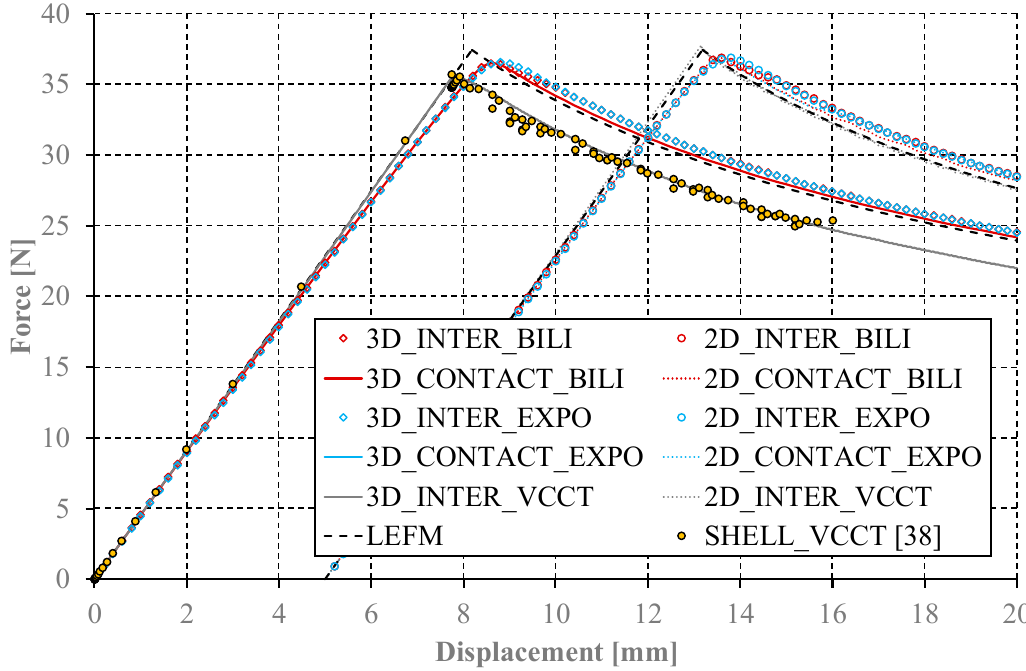
Figure 9. Comparison of the investigated models.